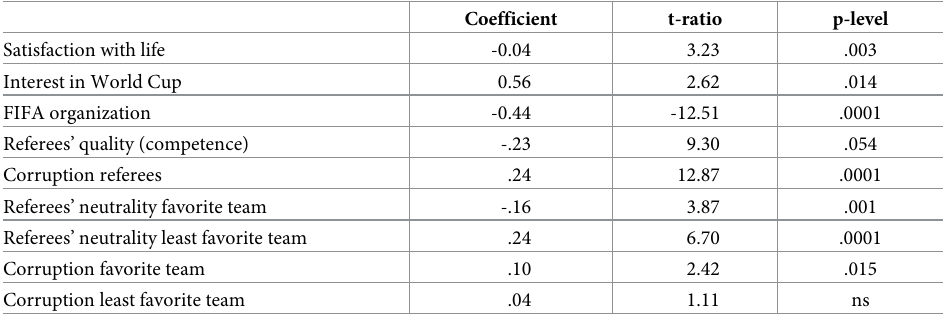
Table 4. Individual level relationships between perceptions of corruption in FIFA and other individual difference measures. Coefficient t-ratio